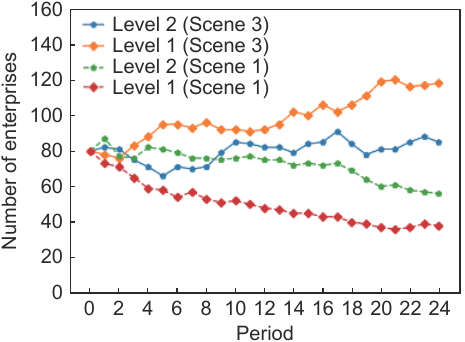
Fig. 7 Scenes 1 and 3: Changes of number of enterprises in Levels 1 and 2.